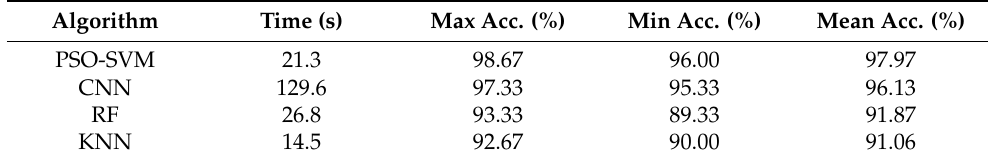
Figure 10. Comparison of classification accuracy with various algorithms. Table 6. Classification results under different algorithms. Table 6. Classification results under different algorithms.